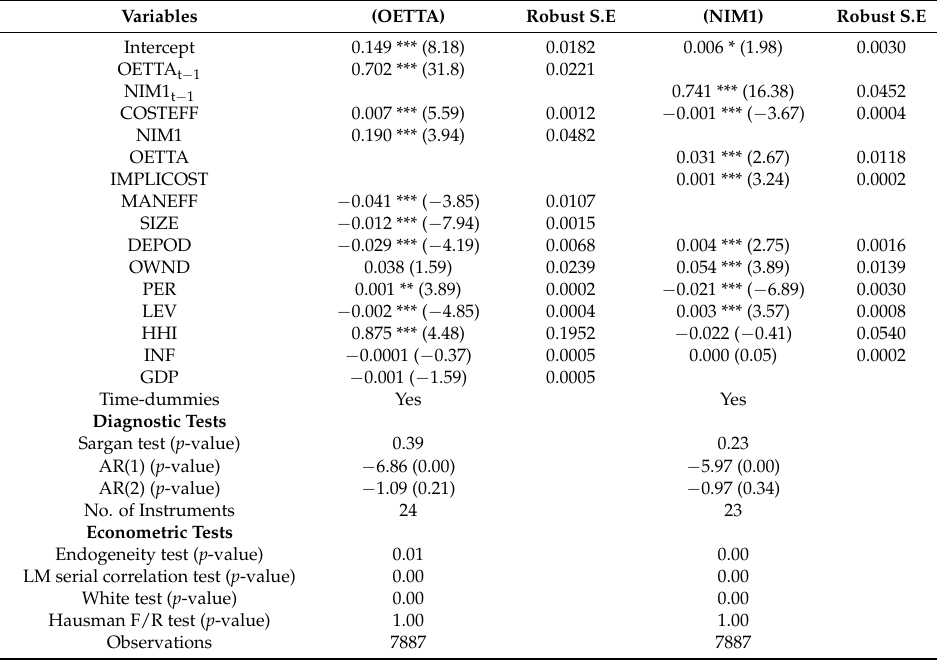
Table 4. Determinants of Equity Capital and Banks’ Intermediation